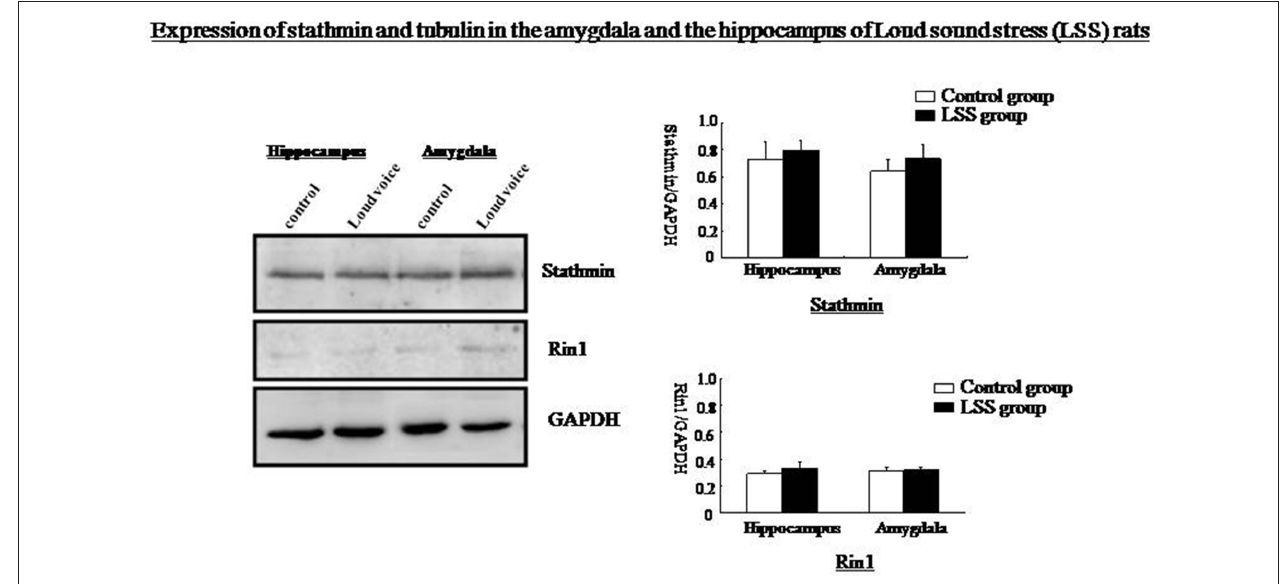
FIGURE 10 | Western blots showing no changes in stathmin or Rin1 expression after the loud sound stimulus.